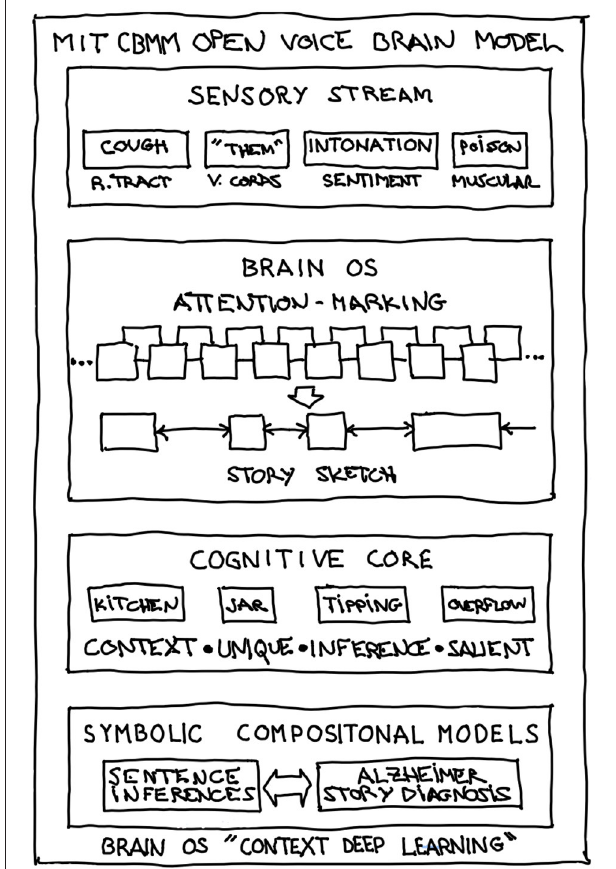
FIGURE 1 | Diagram of MIT CBMM open voice 4 module brain model with the selected AD